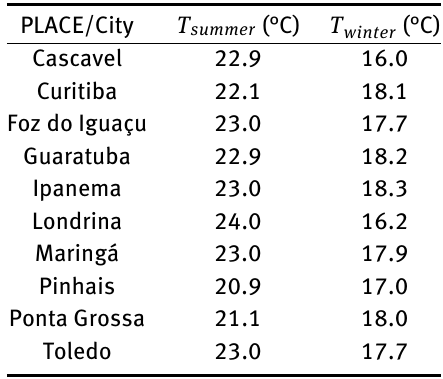
Table 2: Values of geothermal temperatures of summer and winter.